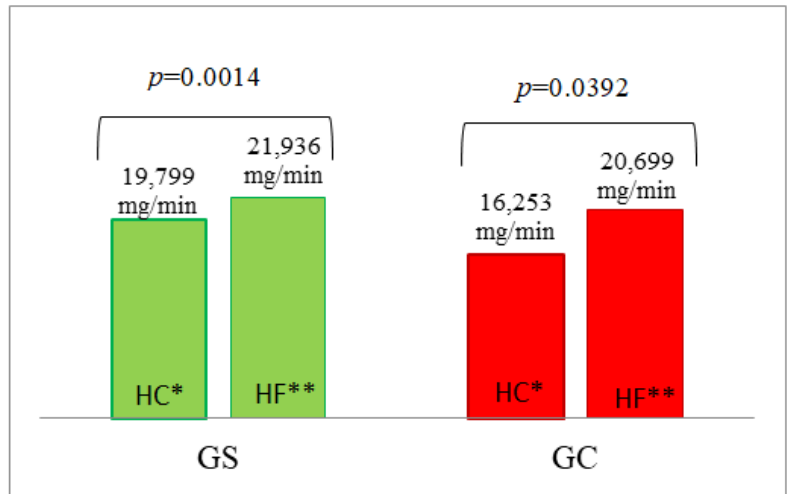
Figure 7. The AUC of lipid oxidation in the G S and G C groups after HC and HF meals. The results are presented as the mean values. * difference between the G S (obese/overweight) and G C (normal body weight) groups after HC meal (high-carbohydrate meal ( p = 0.1909)); ** difference between the G S and G C groups after HF meal (high-fat meal ( p = 1.000)).